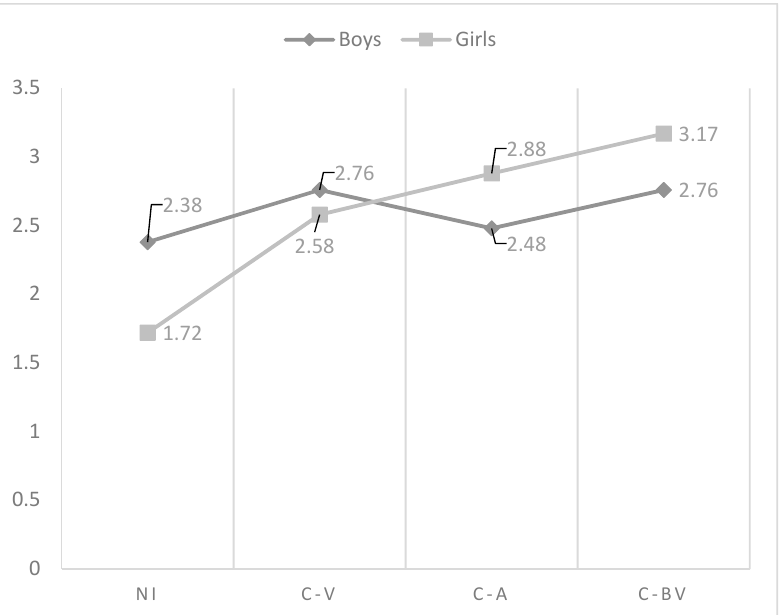
Figure 5. Effect of the interaction of gender and cyberbullying roles on mother response cost. Notes: NI = Non-involved; C-V = Cyber-victim; C-A = Cyber-Aggressor; C-BV = Cyber-bully/victim.